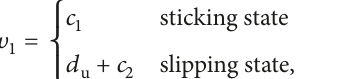
Figure 3: The amplitude-frequency response curves of blade at different rotating